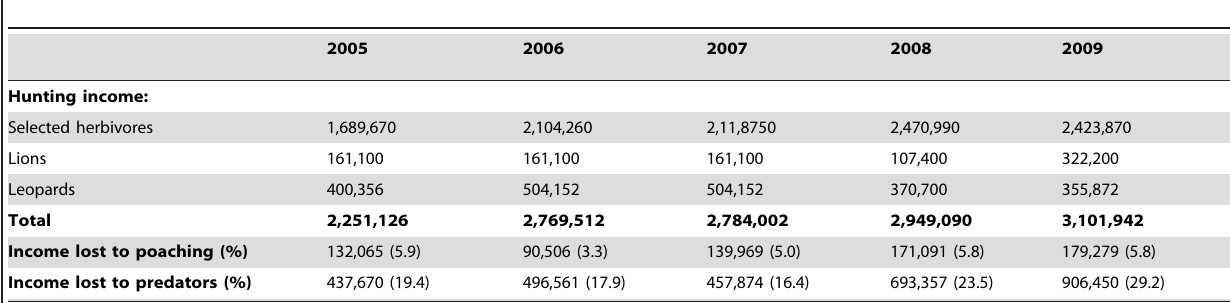
Table 1. The relative gross financial benefits (in US dollars) of trophy hunting ten key herbivores species, leopards and lions, relative to the costs incurred by poaching and